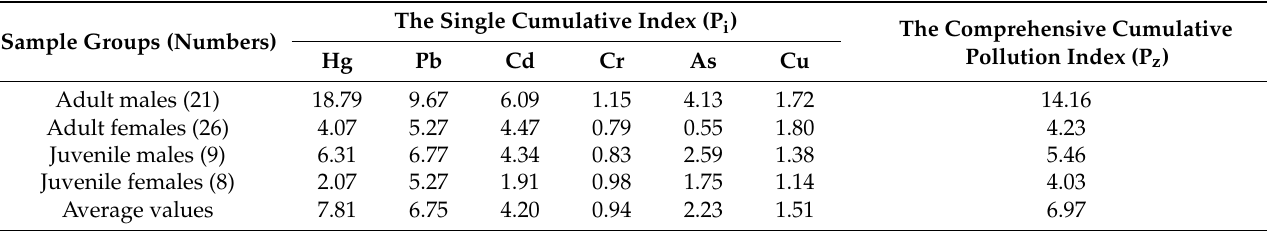
Table 4. The average single cumulative pollution indexes and average comprehensive cumulative pollution indexes of toxic trace elements in human hair in the polluted area.